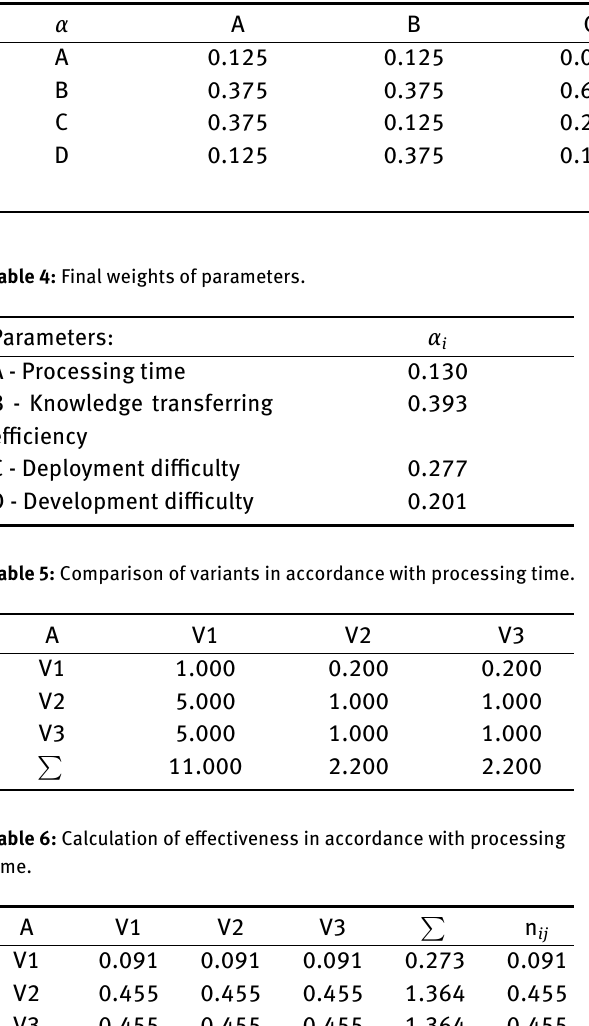
Table 3: Calculating standard weight of parameters.